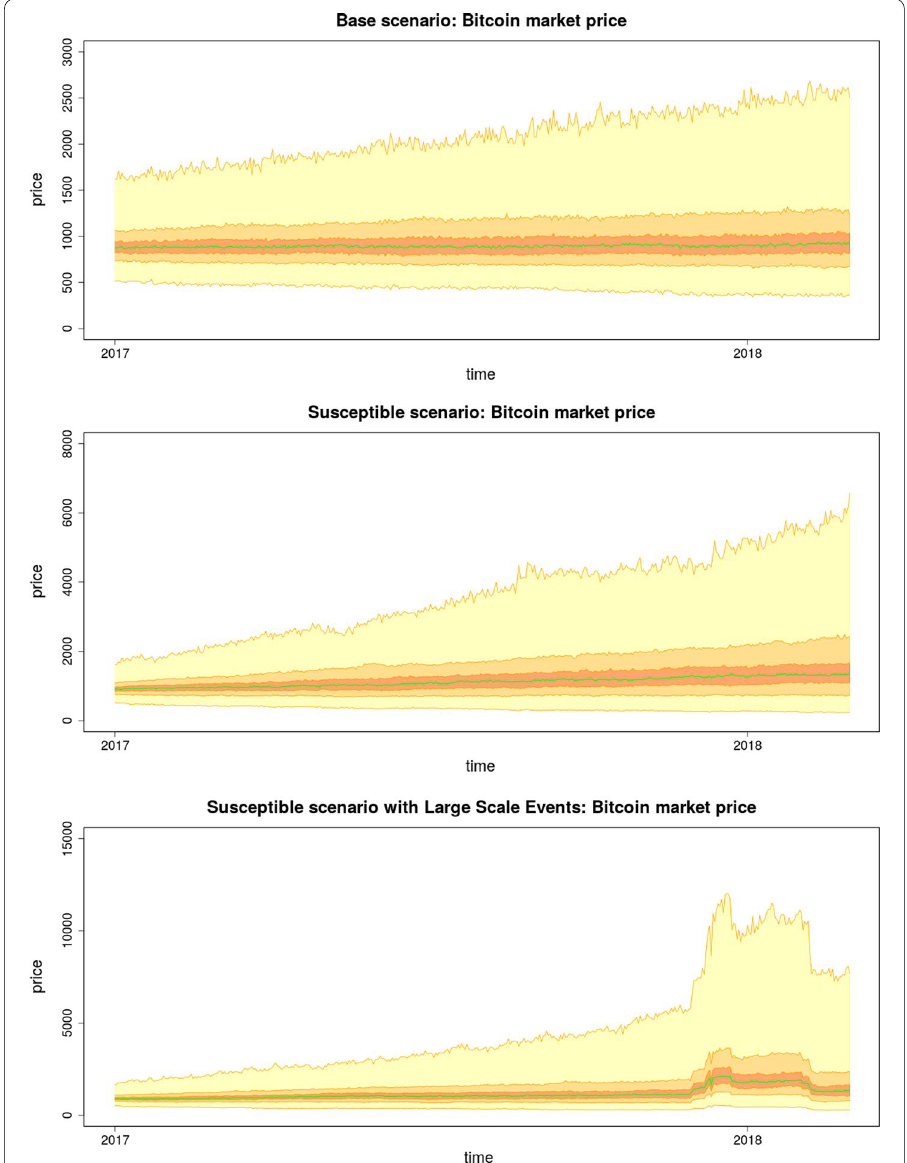
Fig. 3 Simulated market price time series in terms of activity of agents or presence of large scale events. Base scenario with only random agents and random speculative agents; susceptible scenario including Chartist agents; and susceptible scenario with large scale events included in the simulation. The green line is the median price with 20th, 50th and 95th prediction